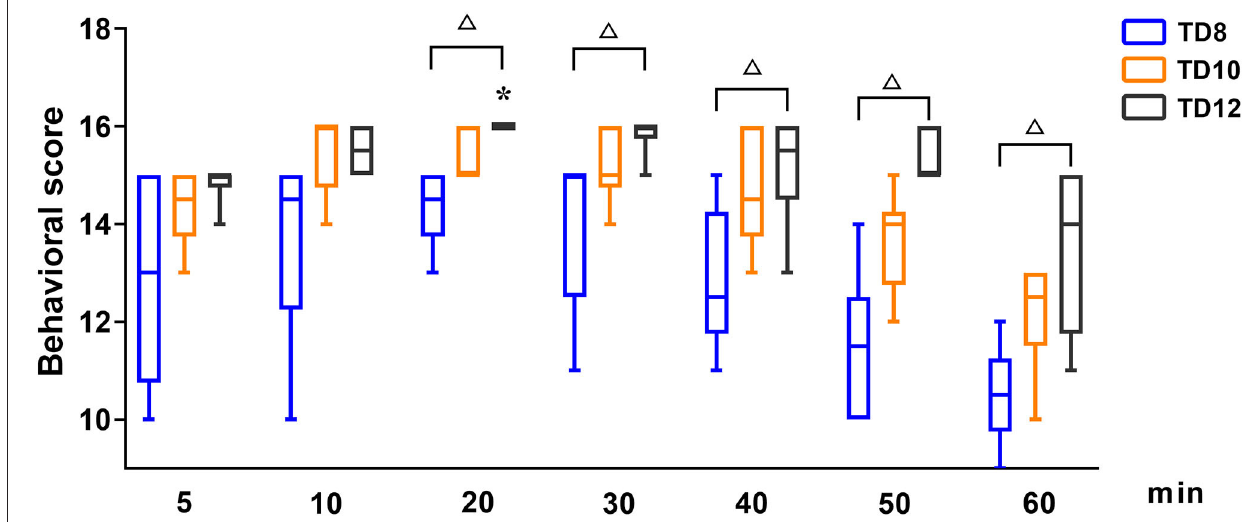
FIGURE 1 | The behavioral scores in dogs undergoing anesthesia with tiletamine and three concentrations of dexmedetomidine at Phase 1. TD8 group ( n = 6), 4.5mg kg − 1 tiletamine plus 8 µ g kg − 1 dexmedetomidine; TD10 group ( n = 6), 4.5mg kg − 1 tiletamine plus 10 µ g kg − 1 dexmedetomidine; TD12 group ( n = 6), 4.5mg kg − 1 tiletamine plus 12 µ g kg − 1 dexmedetomidine. Values are expressed as medians (min–max). *Significantly different from 5min at the same group ( p < 0.05). # Significantly different from TD10 within the same time ( p < 0.05). 1 Significantly different from TD12 within the same time ( p < 0.05).